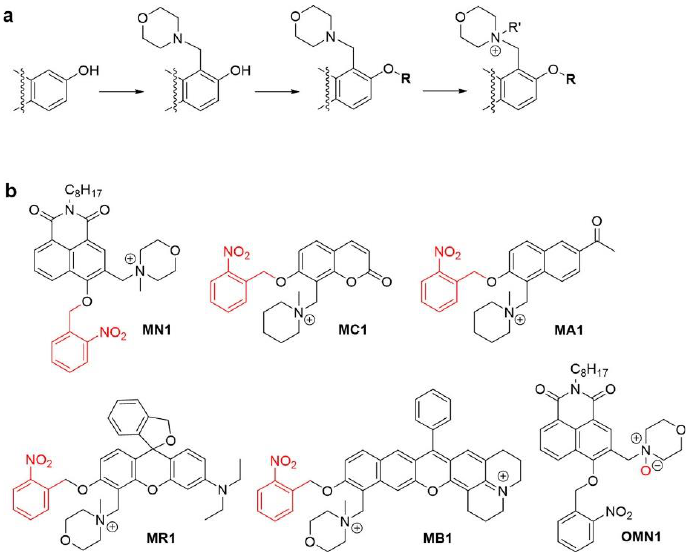
Figure 21. ( a ) Synthesis of the morpholinium derivatives. ( b ) The synthesized, p -nitrobenzyl caged probes. Reprinted with permission from [85], copyright 2022 American Chemical Society.